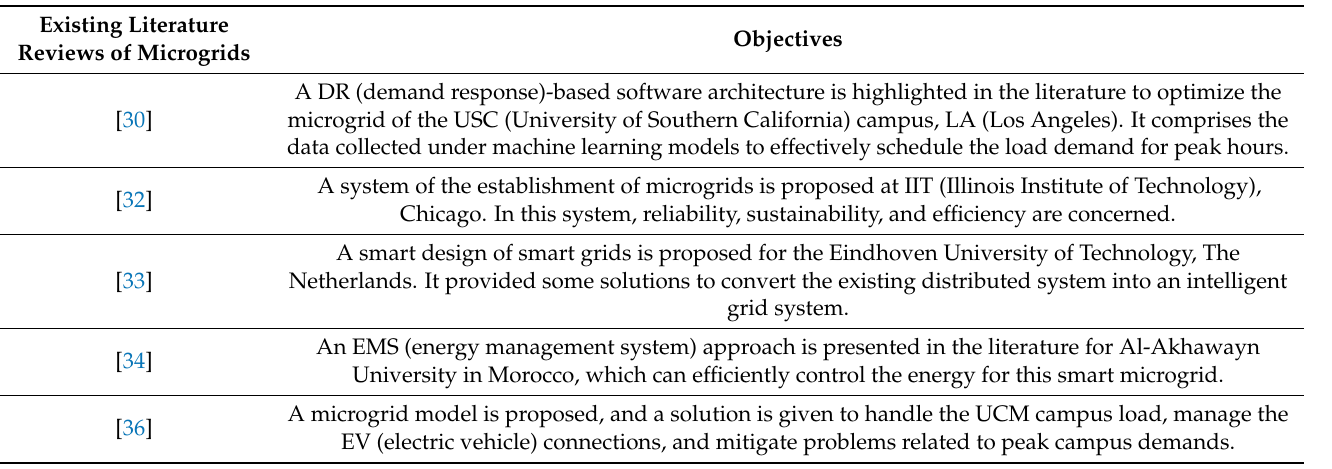
Table 4. Comparison between existing studies of campus microgrids and our survey paper. Existing Literature Reviews of